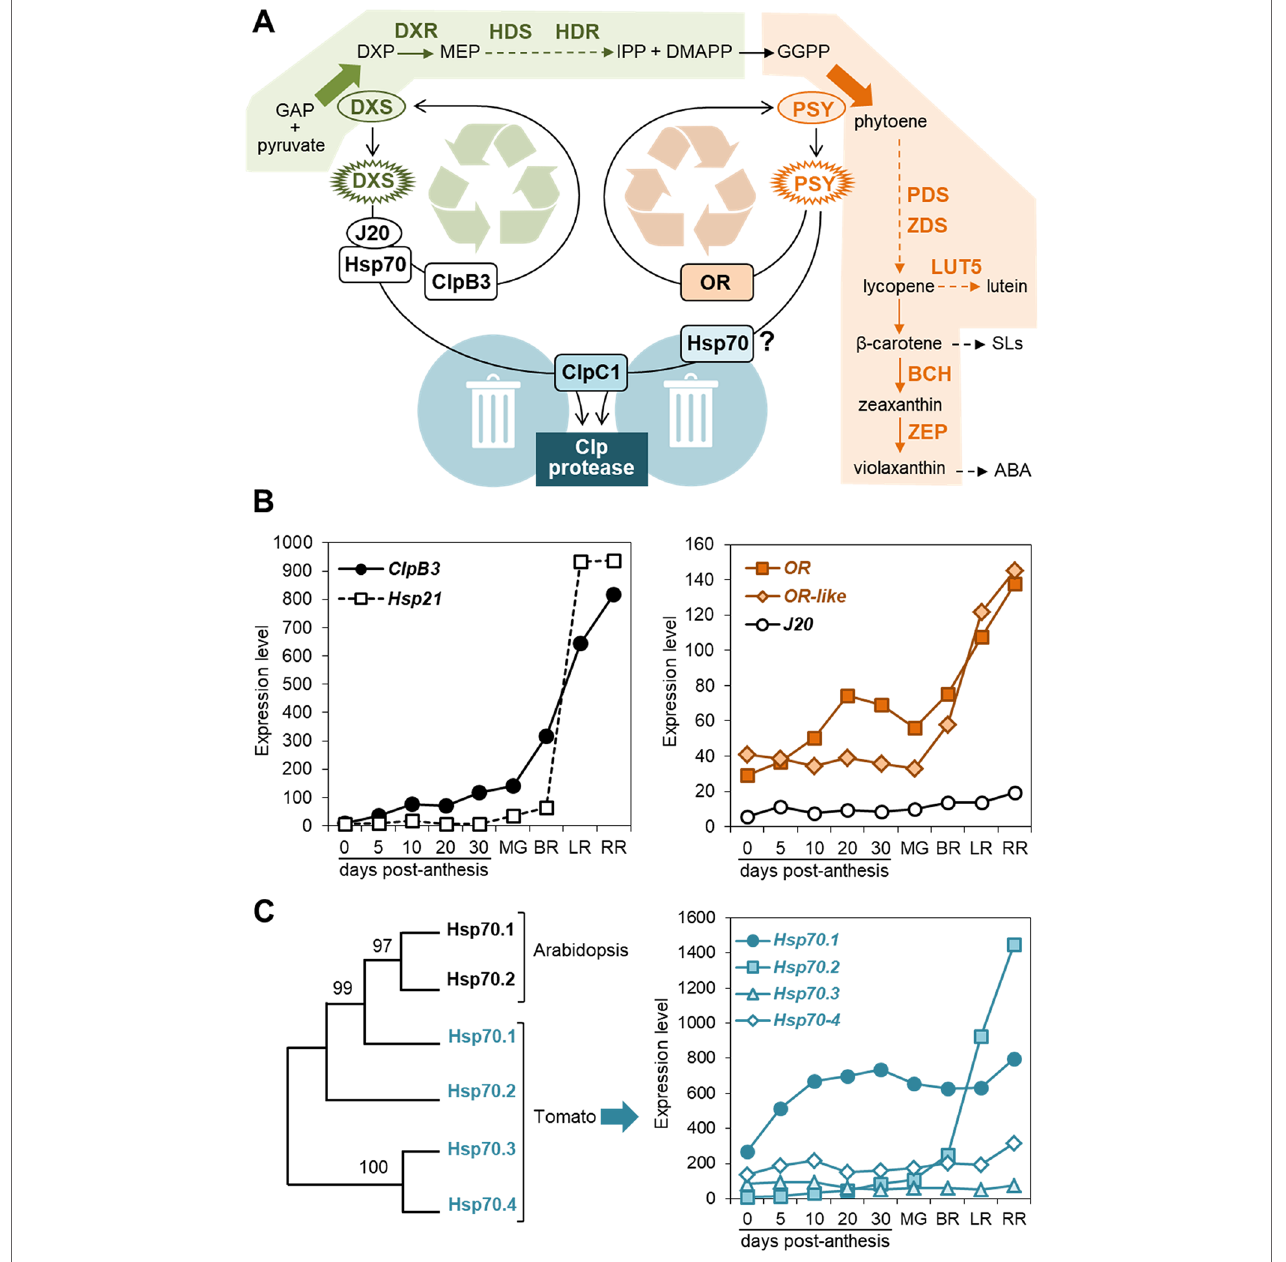
FIGURE 1 | PQC components involved in carotenoid biosynthesis. (A) Model of the regulation of biosynthetic enzymes by PQC components. Metabolite acronyms: GAP, glyceraldehyde 3-phosphate; DXP, deoxyxylulose 5-phosphate; MEP, methylerythritol 4-phosphate; IPP, isopentenyl diphosphate; DMAPP, dimethylallyl diphosphate; GGPP, geranylgeranyl diphosphate; SLs, strigolactones; ABA, abscisic acid. Dashed arrows represent several steps. The MEP pathway (boxed in green) provides substrates for the carotenoid pathway (boxed in orange). DXS and PSY catalyze the main flux-controlling steps of these pathways (large arrows). When active enzymes (oval) misfold or/and aggregate (spiked), specific chaperones participate in their unfolding for either reactivation or removal. DXS and PSY are degraded by the stromal Clp protease, a complex that also appears to control the levels of the indicated enzymes (bold): DXR, DXP reductoisomerase; HDS, hydroxymethylbutenyl diphosphate (HMBPP) synthase; HDR, HMBPP reductase; PDS, phytoene desaturase; ZDS, zeta-carotene desaturase; LUT5, cytochrome P450 beta-hydroxylase; BCH, non-heme di-iron beta-hydroxylase; ZEP, zeaxanthin epoxidase. (B) Expression levels of the indicated chaperone genes during tomato fruit development. Data from the Tomato Expression Atlas (http://tea.solgenomics.net/) were plotted to show the levels of transcripts encoding ClpB3 (Solyc02g088610), Hsp21 (Solyc03g082420), OR (Solyc03g093830), OR-like (Solyc09g010110) and J20 (Solyc05g053760) in fruit at several stages after anthesis. MG, mature green (equatorial pericarp); BR, breaker (equatorial pericarp); LR, light red (total pericarp); RR, red ripe (total pericarp). (C) Plastidial Hsp70 family members and their expression levels during tomato fruit development. The left panel shows a Maximum Likelihood unrooted tree constructed with MEGA6 using Arabidopsis Hsp70.1 (At4g24280) and Hsp70.2 (At5g49910) and tomato Hps70.1 (Solyc01g103450), Hsp70.2 (Solyc11g020040), Hsp70.3 (Solyc01g106260), and Hsp70.4 (Solyc01g106210) protein sequences lacking their predicted plastid-targeting sequences (http://www.cbs.dtu.dk/services/TargetP/). The graph on the right was made as described in (B)